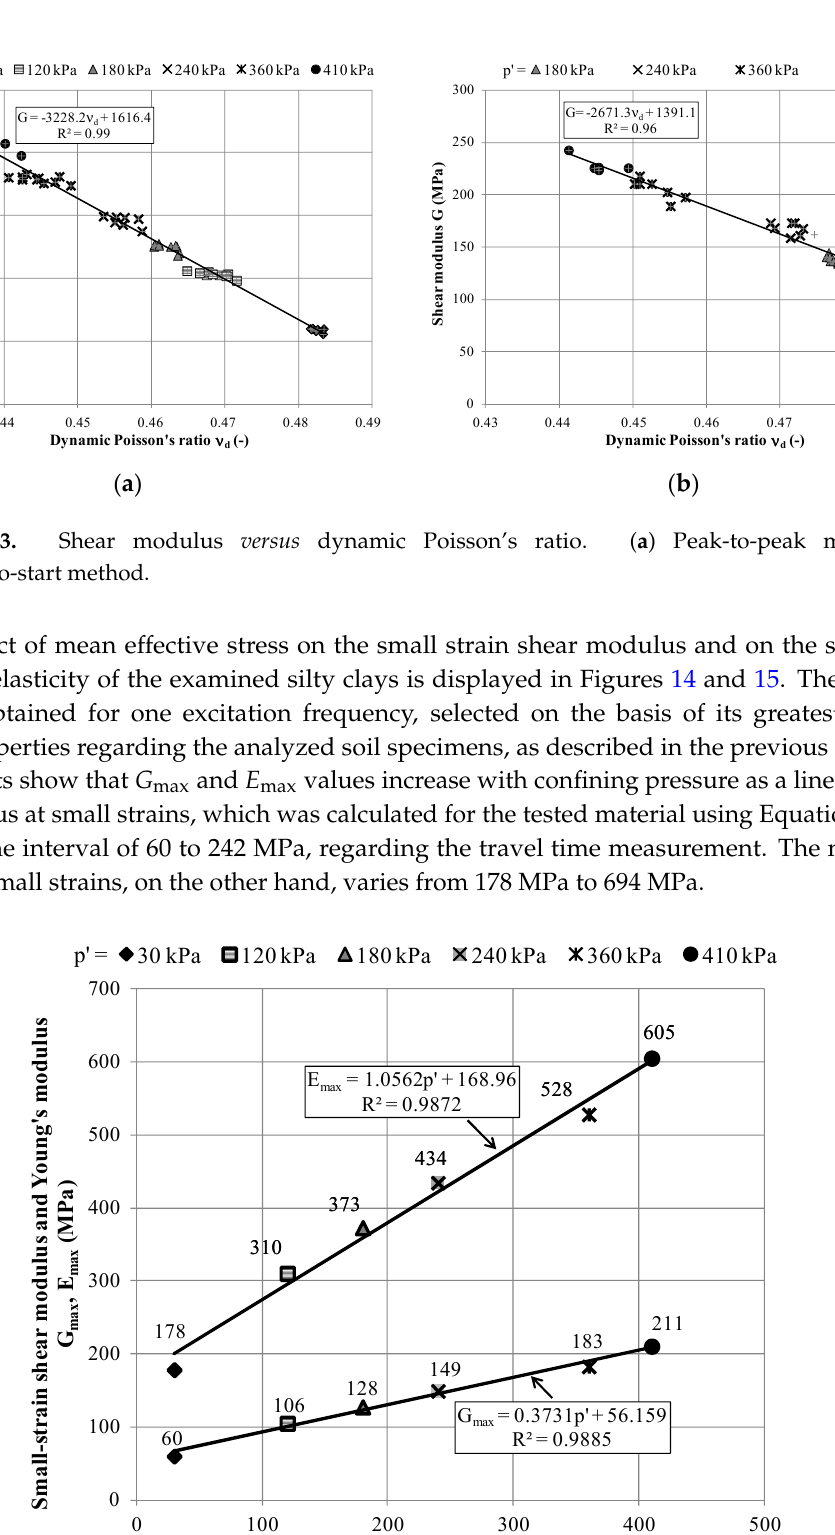
Figure 14. Elastic moduli from the peak-to-peak method under different stress levels.